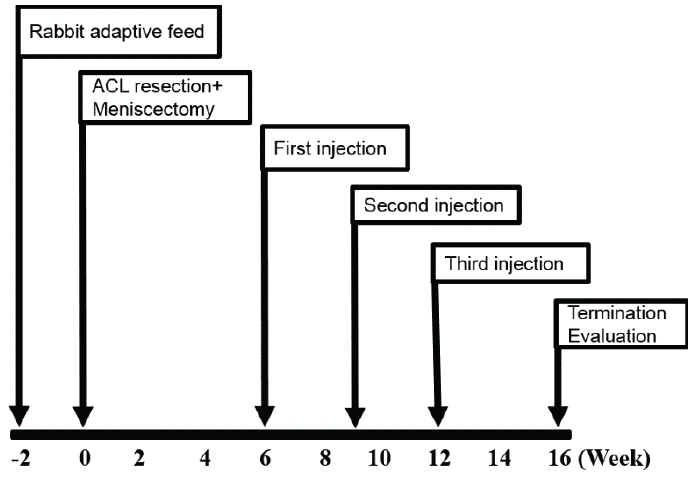
Figure 8. Experimental